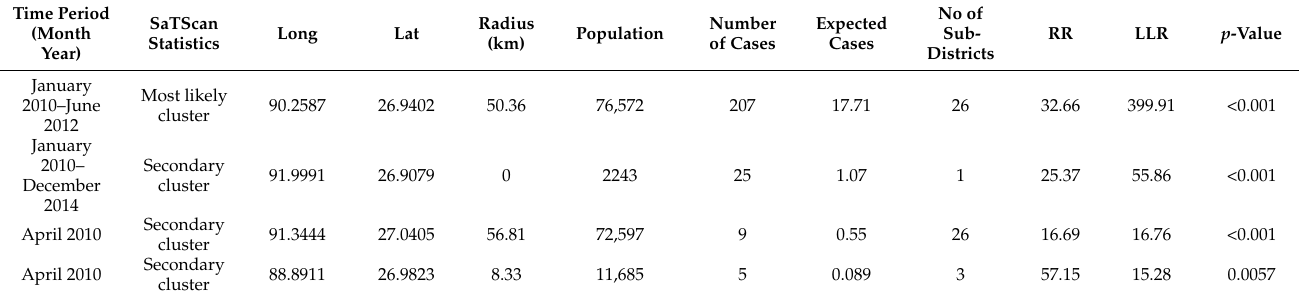
Table 4. Significant Plasmodium falciparum space–time clusters at sub-district level in Bhutan,